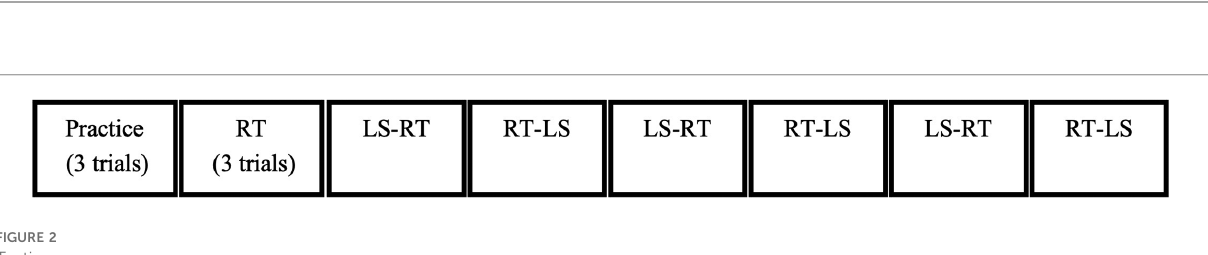
FIGURE 2 Testing